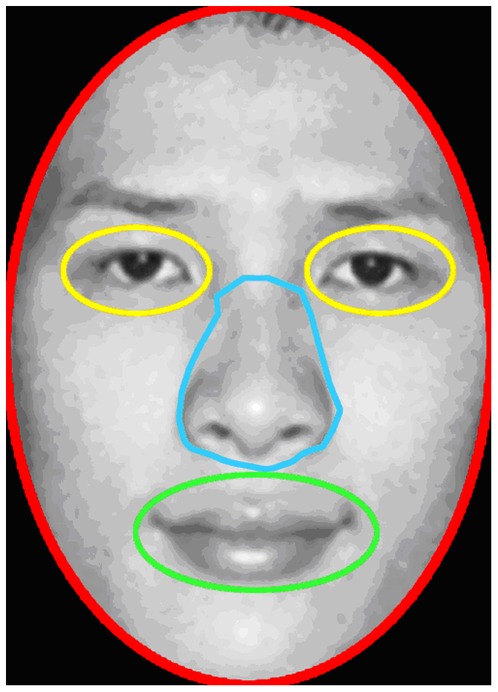
Example of areas of interest (AOI) plots.